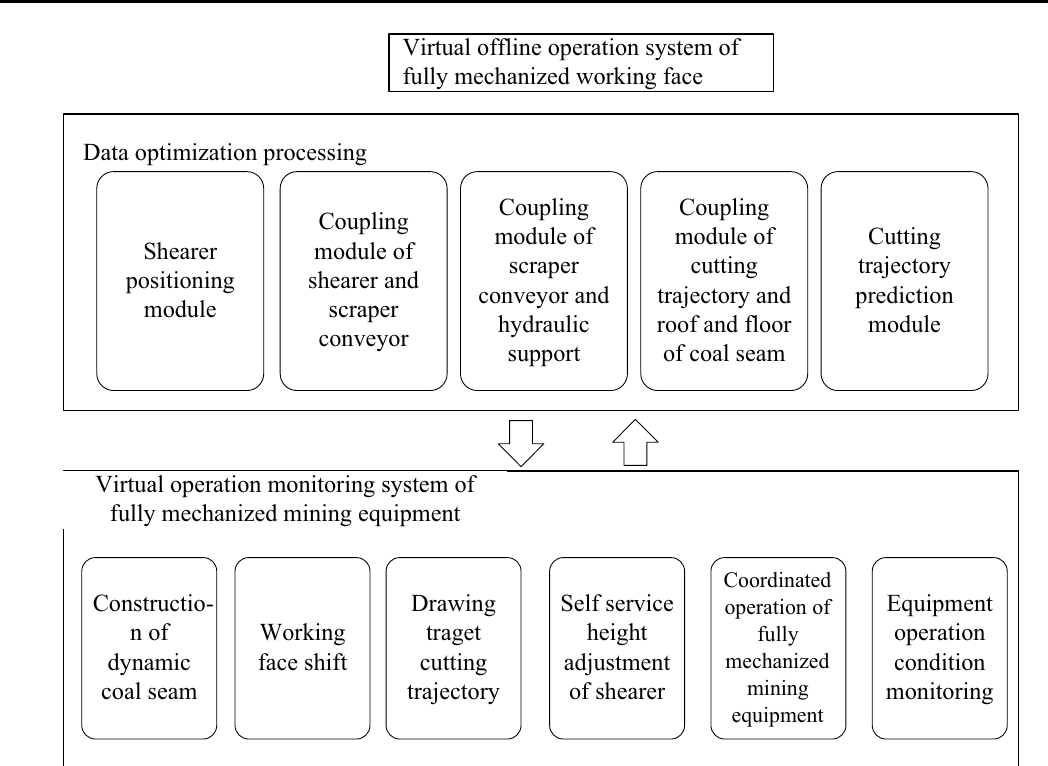
Fig. 6 Offline operation simulation